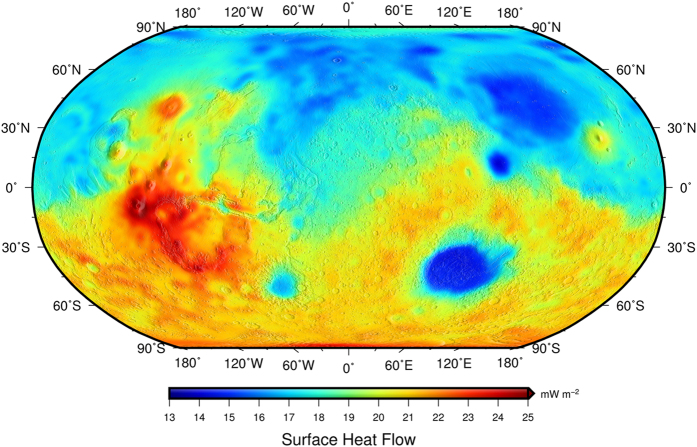
Preferred present-day surface heat flow model (the FNPR-based model) for Mars (sampled on a 2° × 2° grid), constructed by scaling heat flow variations related to variations in crustal thickness and topography, assuming constant mantle heat flow, and using the heat flow obtained for the NPR from the effective elastic thickness as an anchoring value.